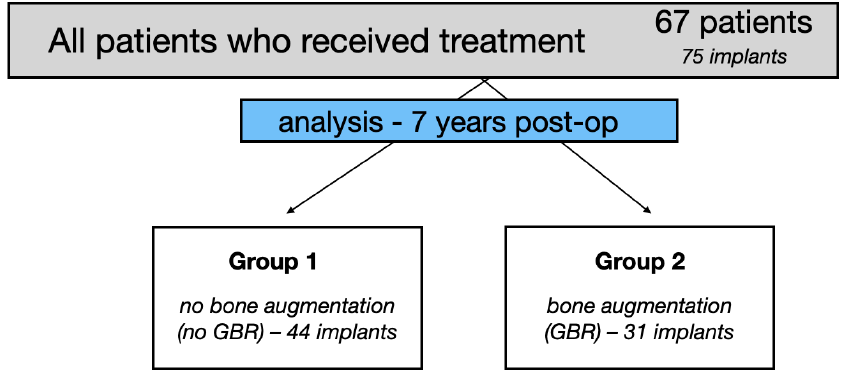
Figure 1. Allocation of patients, size of the groups. Guided bone regeneration (GBR) G1 — no